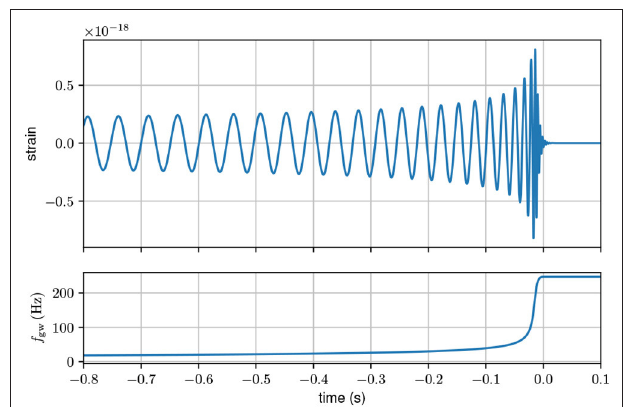
FIGURE 5 | Typical GW signal of a compact binary coalescence. The GW strain (above) and the GW frequency (below) are plotted as function of the time before merging. This waveform is a template of the first event detected GW150914 ( Vallisneri et al.,